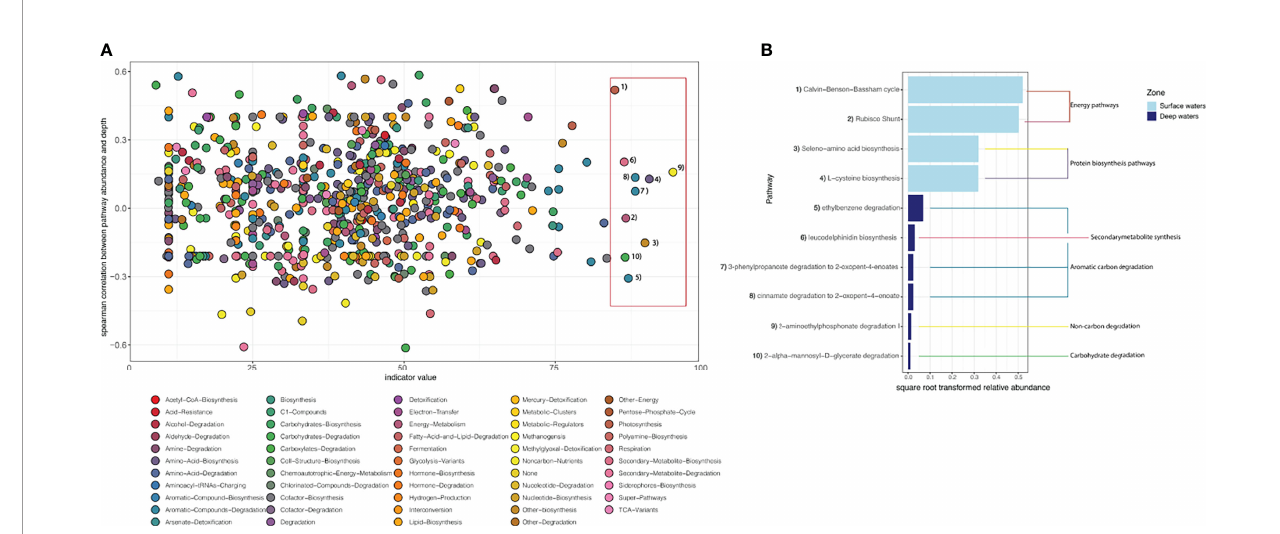
FIGURE 5 | Indicator metatranscriptomic pathways for surface and deep zones. (A) scatterplot of the Spearman correlation coef fi cient for metatranscriptomic pathways and depth zones vs indicator value, coloured by metabolic pathway type, shown at the bottom of the fi gure. Dots labelled with numbers and outlined by the pink rectangle are those that have a signi fi cant (p <0.05) indicator value of > 85 and correspond with the indicator metatranscriptomic pathways shown in (B), demonstrating each pathway ’ s relative abundance and whether they are indicators for the surface or deep ocean. Relative abundance was square root transformed to aid visualization. The broader functional MetaCyc classes to which each pathway belongs are shown by the coloured